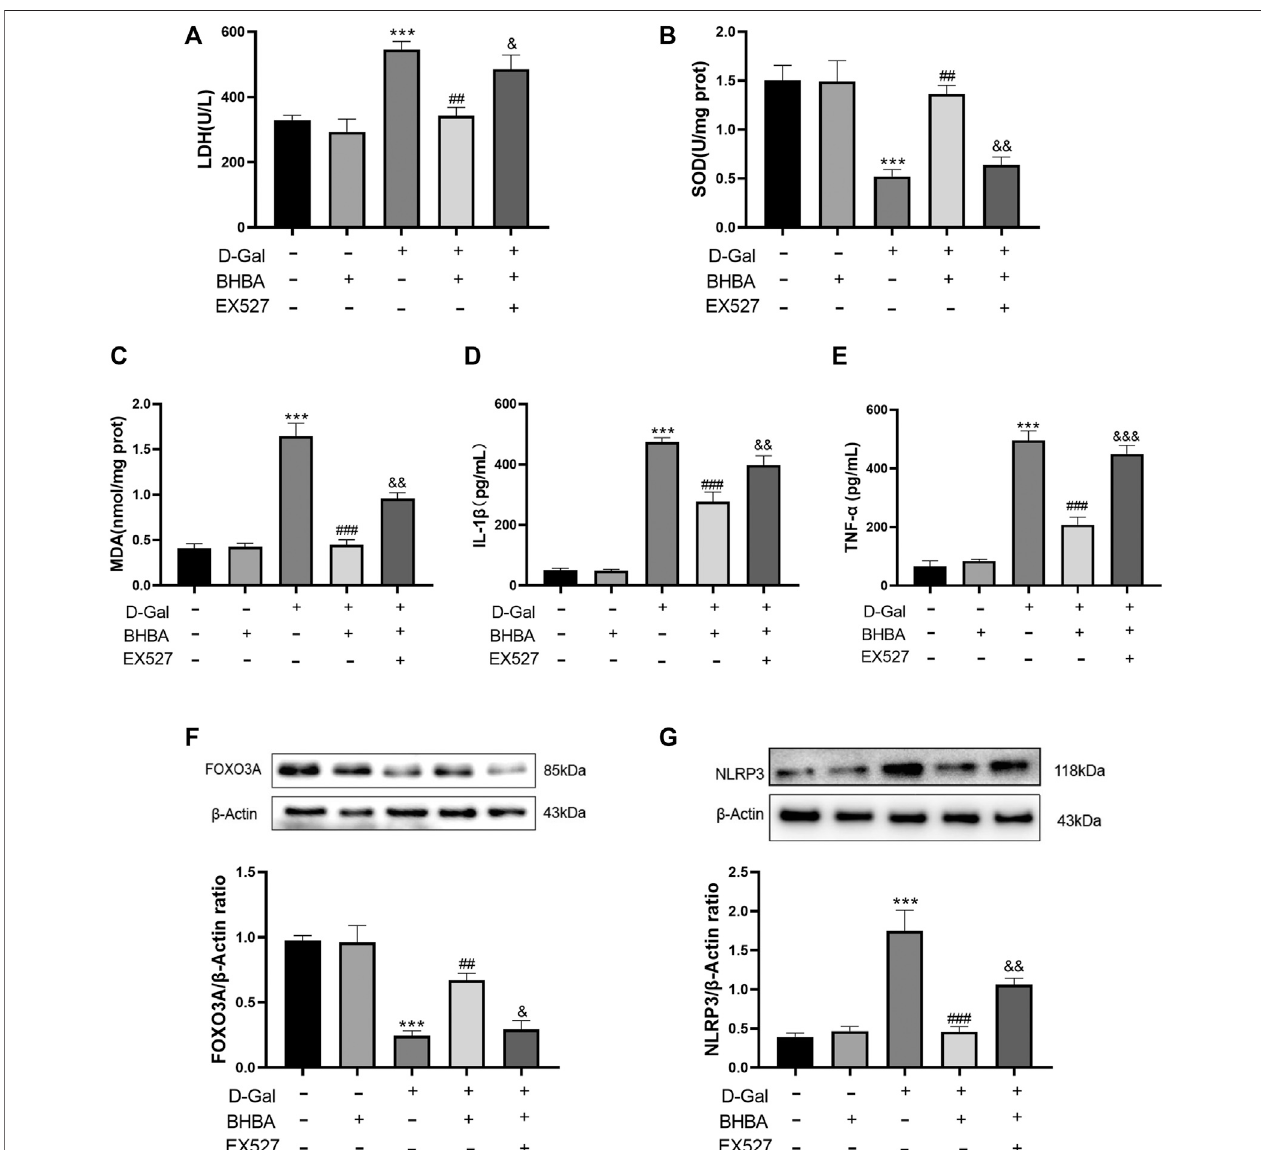
FIGURE7| In fl uenceofSIRT1inhibitorEX527ontheeffectsofBHBAonD-gal-inducedHT22cells. (A) ActivityofLDH. (B) ActivityofSOD. (C) ContentofMDA. (D) Content of IL-1 β . (E) Content of TNF- α . (F) Protein expression of FOXO3A. (G) Protein expression of NLRP3. D-gal: 200 mM; BHBA: 20 mM; EX527: 1 μ M, n (cid:1) 3 – 5. Compared with the control group, *** p < 0.001; compared with the D-gal group, ## p < 0.01, ### p < 0.001; compared with the D-gal + BHBA group, & p < 0.05, && p < 0.01, &&& p < 0.001.